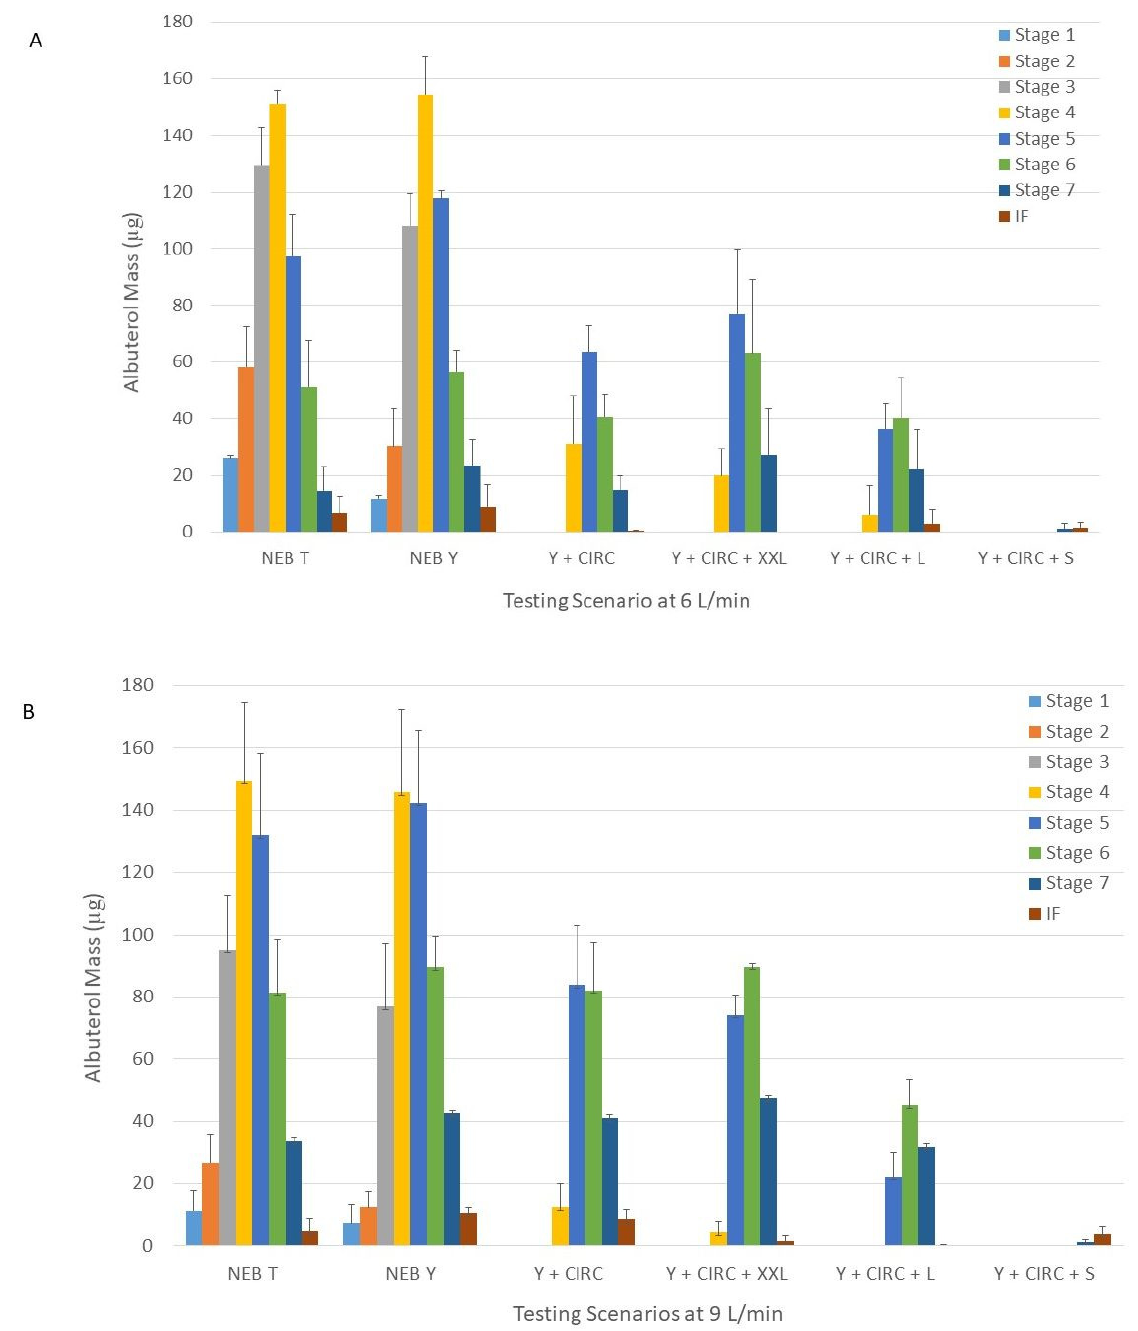
Figure 1. Drug distribution across the different stages of the Next Generation Impactor with nebulizers with the Tee-piece, with the Tee-piece connected to the Y-piece, with the Tee-piece connected to the Y-piece connected to the humidifier and circuit, and with the Tee-piece connected to the Y-piece connected to the humidifier, circuit, and small, large, and XXL cannulas and operated at 6 (panel ( A )) and 9 L/min (panel ( B )), respectively. Panel A = 6 L/min. Panel B = 9 L/min. NEB T = nebulizer with the Tee-piece. NEB Y = nebulizer with the Tee-piece connected to the Y-piece. Y + CIRC = nebulizer with the Tee-piece connected to Y-piece connected to the humidifier and circuit. Y + CIRC + XXL = nebulizer with the Tee-piece connected to the Y-piece connected to the humidifier, circuit, and XXL cannula. Y + CIRC + L = nebulizer with the Tee-piece connected to the Y-piece connected to the humidifier, circuit, and large cannula. Y + CIRC + S = nebulizer with the Tee-piece connected to the Y-piece connected to the humidifier, circuit, and small cannula.